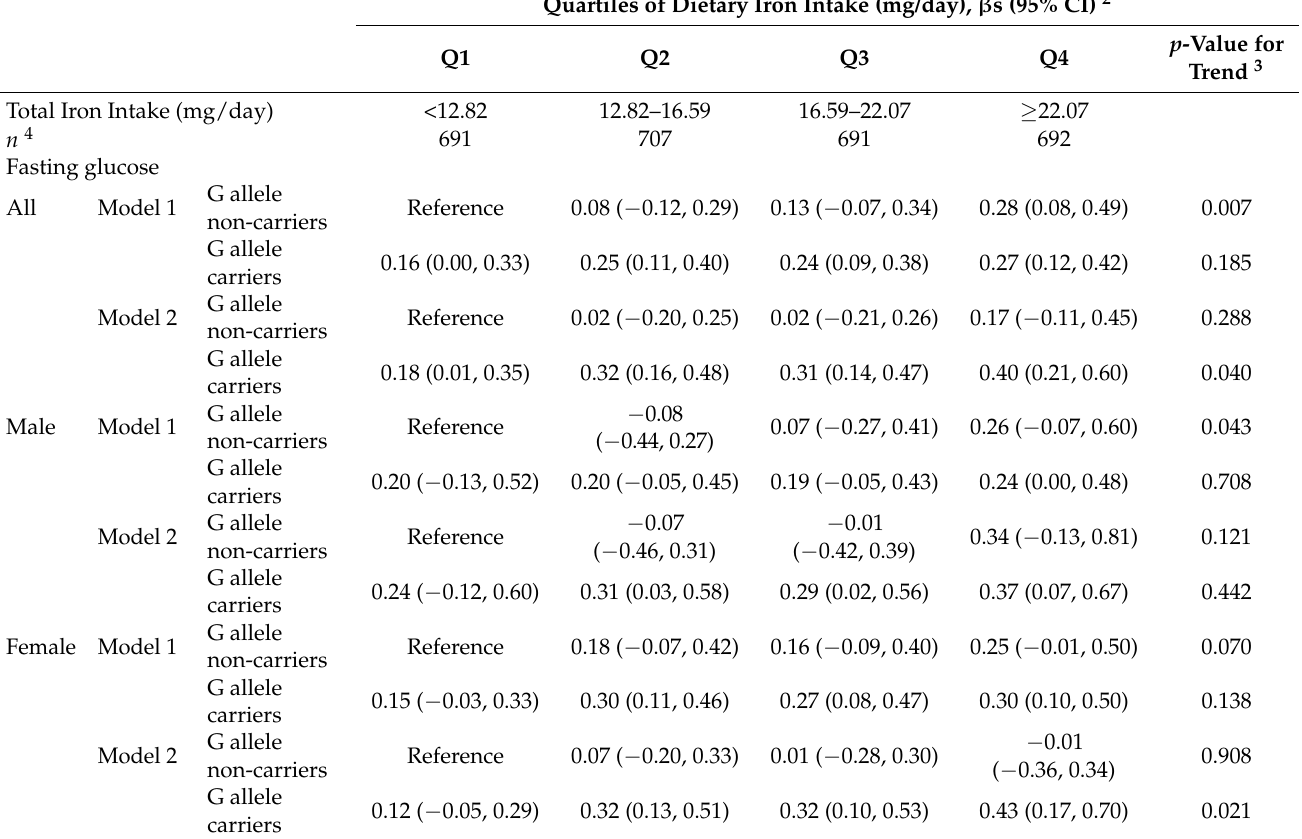
Table 4. β s (95% CI) for fasting glucose according to the quartiles of dietary iron, stratified by the G allele of rs10830963 in the MTNR1B gene among the participants 1